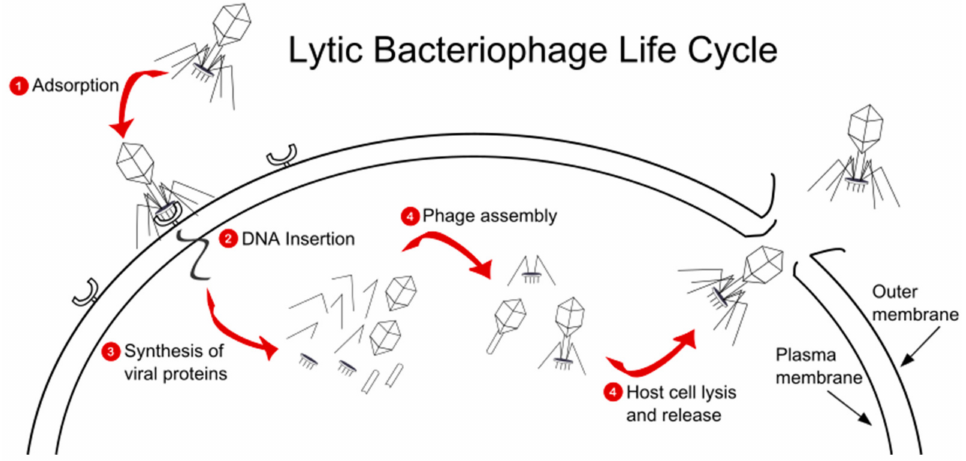
Figure 1. Representation of the lytic P. aeruginosa phage life